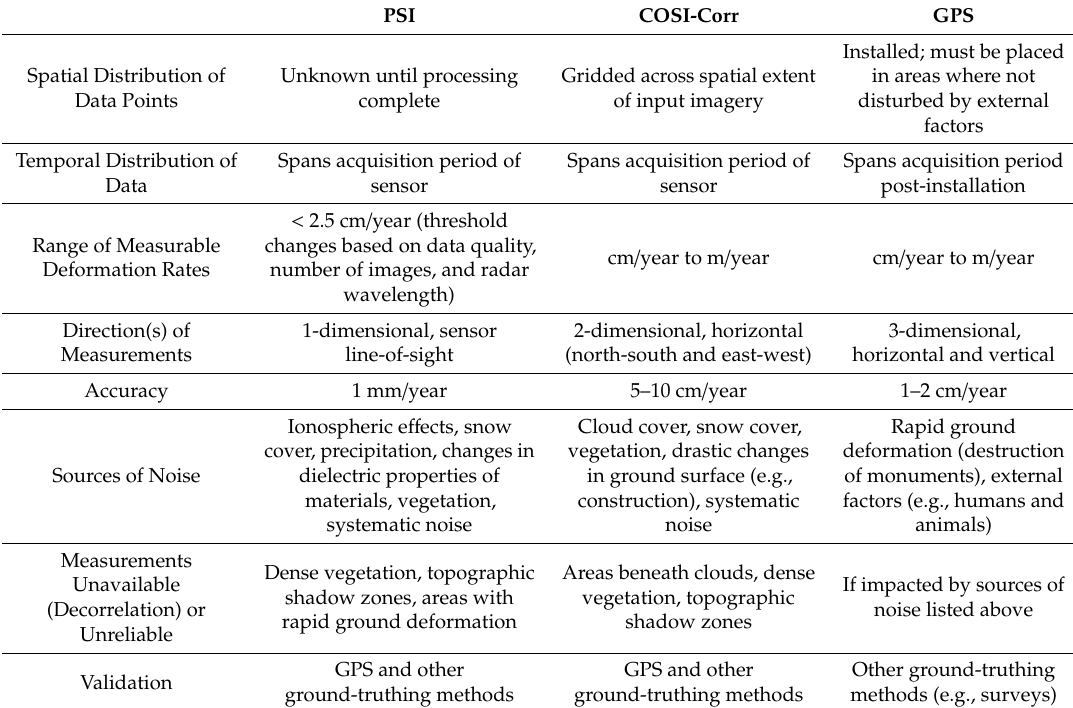
Table 1. Variables to consider prior to mapping and monitoring of landslides using Persistent